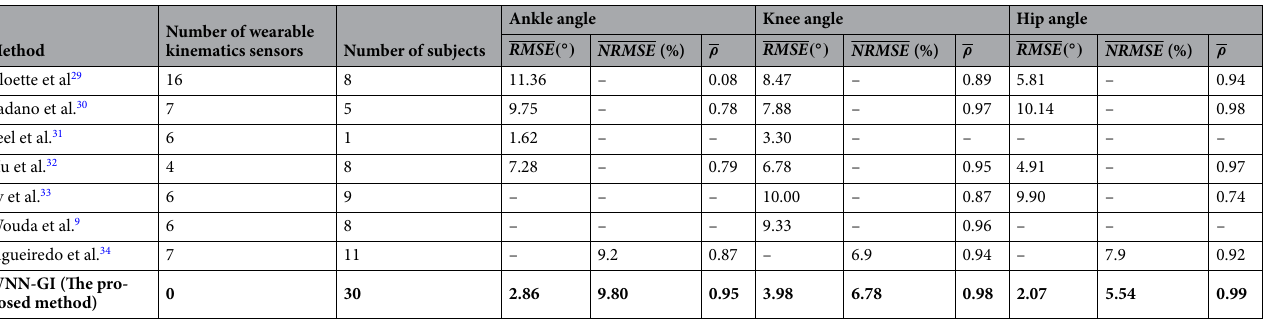
Table 1. Accuracies of the proposed WNN-GI method versus related literature. Bold font emphasizes the results of the proposed method. The last row is bolded to emphasise the results of the proposed